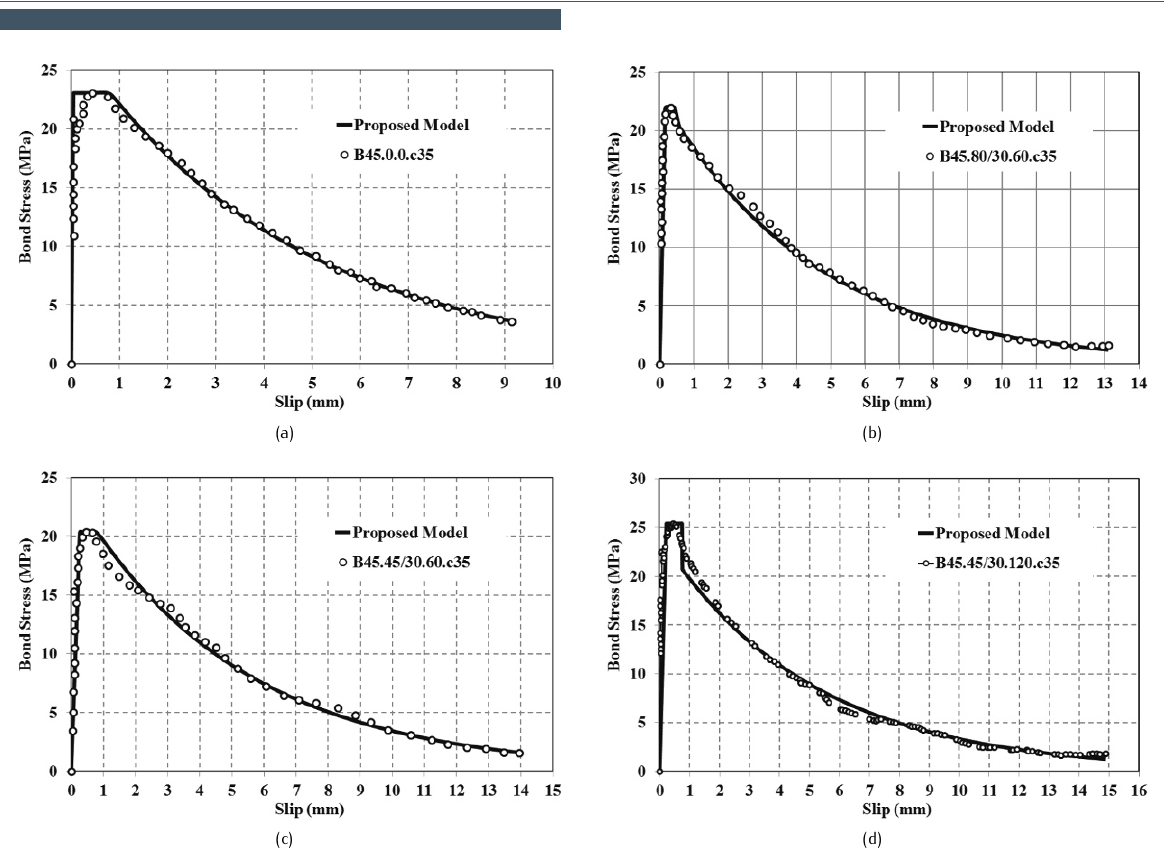
Figure 15. Comparison of the experimentally obtained load-slip curves (Schumacher [30]) versus the predicted curves by using the proposed model for (a) f 0 c = 45 , without fiber and concrete cover = 35, (b) f 0 c = 45 , with fiber “aspect ratio: 80/30” and “fiber content: 60 (kg/m 3 )”, and concrete cover = 35, (c) f 0 c = 45 , with fiber “aspect ratio: 45/30” and “fiber content: 60 (kg/m 3 )”, and concrete cover = 35, and (d) f 0 c = 45 , with fiber “aspect ratio: 45/30” and “fiber content: 120 (kg/m 3 )”, and concrete cover =